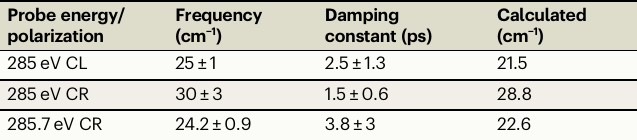
Table 1 | Parameters of the fi t of the temporal traces using damped sine functions (see Supplementary Table 1 for details) Probe energy/